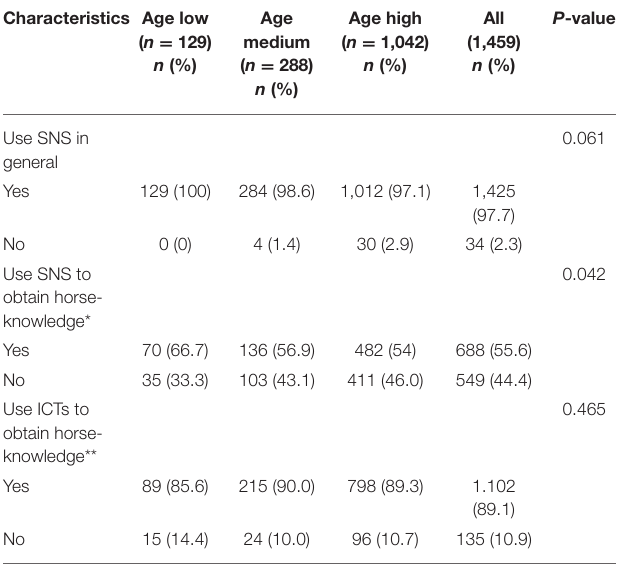
TABLE 2 | Characteristics of Swedish and Norwegian riders’ use of ICTs in relation to age. Characteristics Age low ( n = 129)